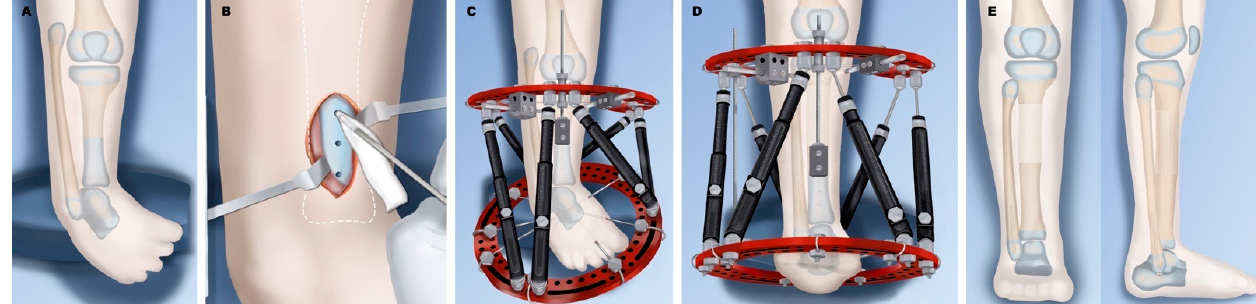
Figure 5. Treatment of Paley type 2C. ( A ) Distal tibia cartilaginous anlage with no physis. ( B ) Insertion of bone morpho-